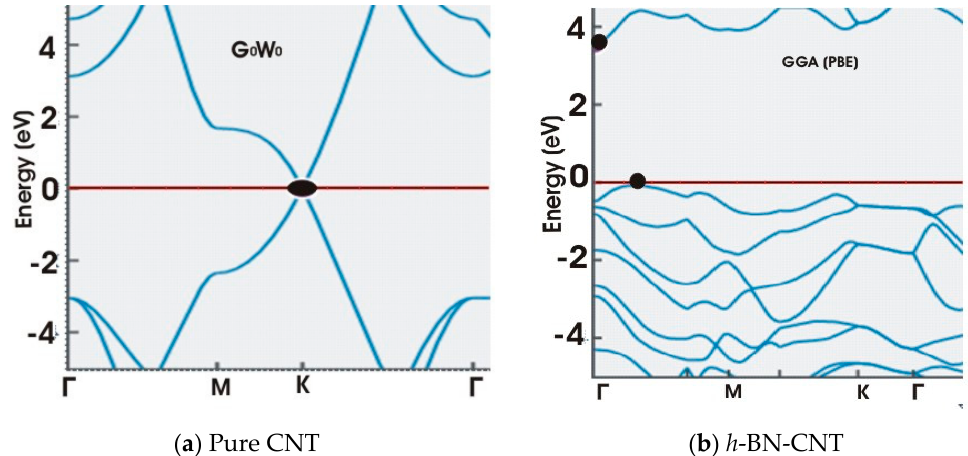
Figure 10. Band structures of ( a ) pure CNT sample showing zero bandgaps, whereas, ( b ) h -BN-CNT showing band gap created as a result of h -BN doping.